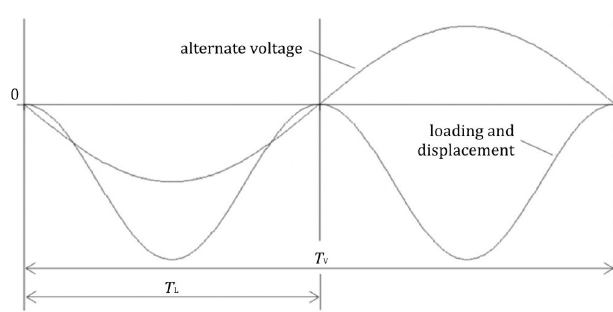
Figure 8: Comparison between actuation voltage cycle and fatigue load cycle for design